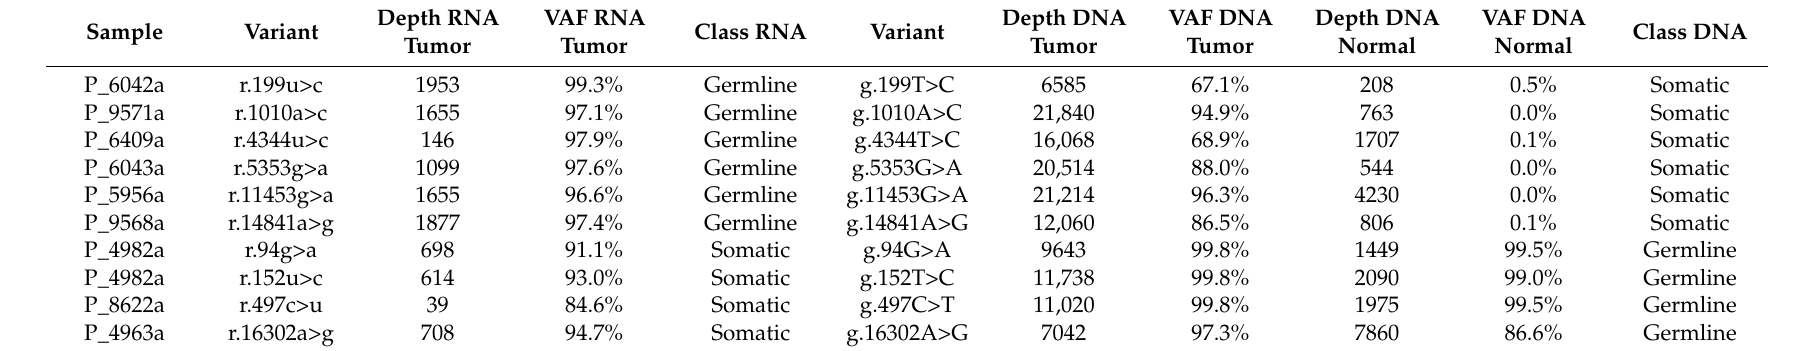
Table A1. Positions misclassified at RNA versus DNA.